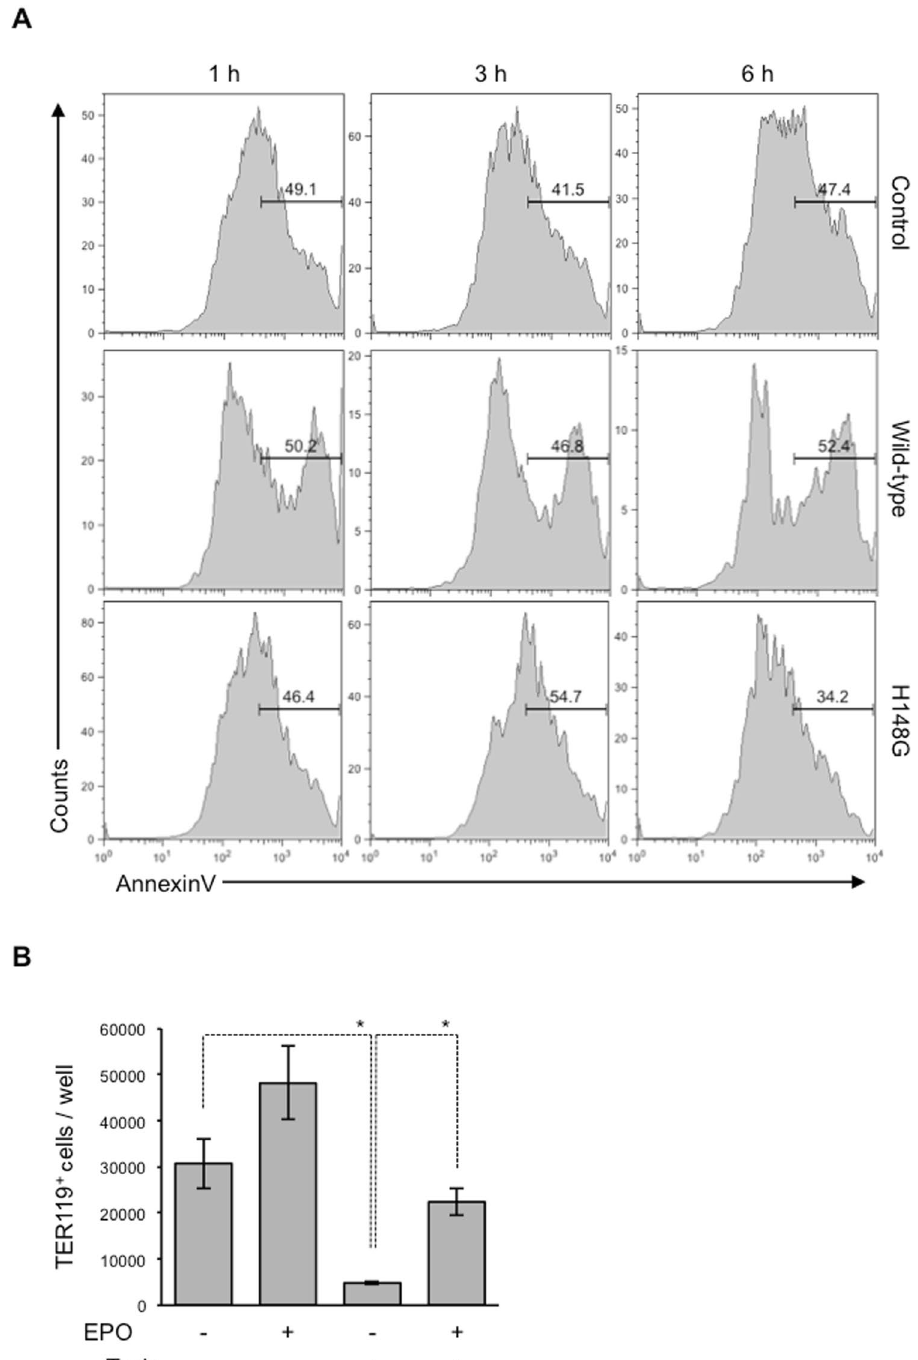
Figure 3. Erythropoietin attenuates the reduction in erythroblasts by α -toxin. ( A ) A total of 5 × 10 5 bone marrow cells were cultured for 1, 3, or 6 hours in the presence or absence (Control) of 100 ng/ml α -toxin (Wild- type) or a variant α -toxin (H148G), and flow cytometry analysis was performed. The frequency of annexinV + cells in the TER119 + cell population was determined. ( B ) A total of 5 × 10 6 bone marrow cells were cultured for 24 hours in the presence of 10 ng/ml α -toxin ( α -toxin) and 1 U/ml recombinant human EPO. The absolute number of TER119 + cells per culture well was determined by flow cytometry. One-way ANOVA was employed to assess statistical significance. Values are mean ± standard deviation. * P <